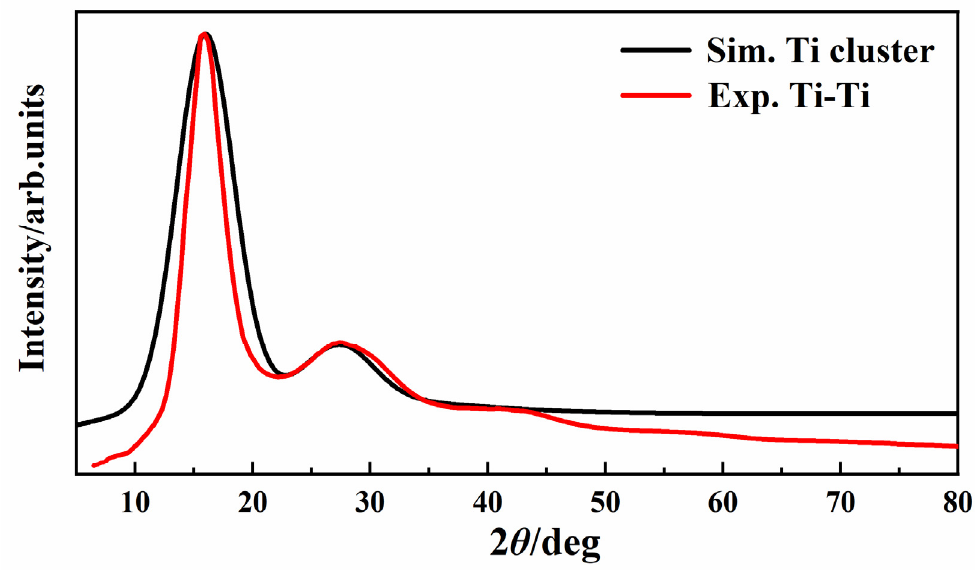
Figure 4. Comparison of the experimental partial Ti–Ti XRD pattern with the simulated Ti cluster.